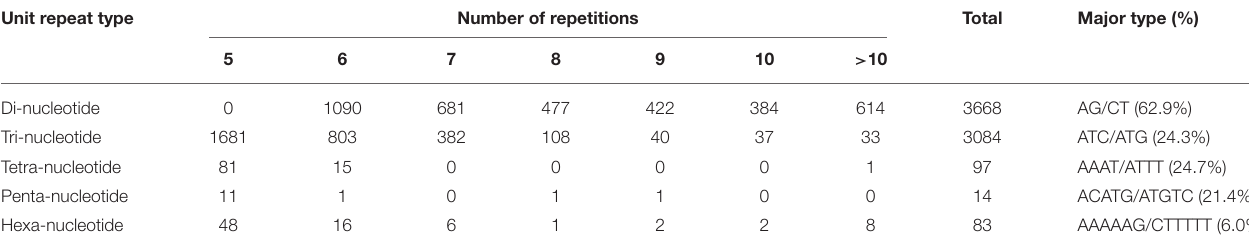
TABLE 7 | Summary of putative SSR identified in the ‘Galatina’ unigenes: sizes, frequencies and major types. Unit repeat